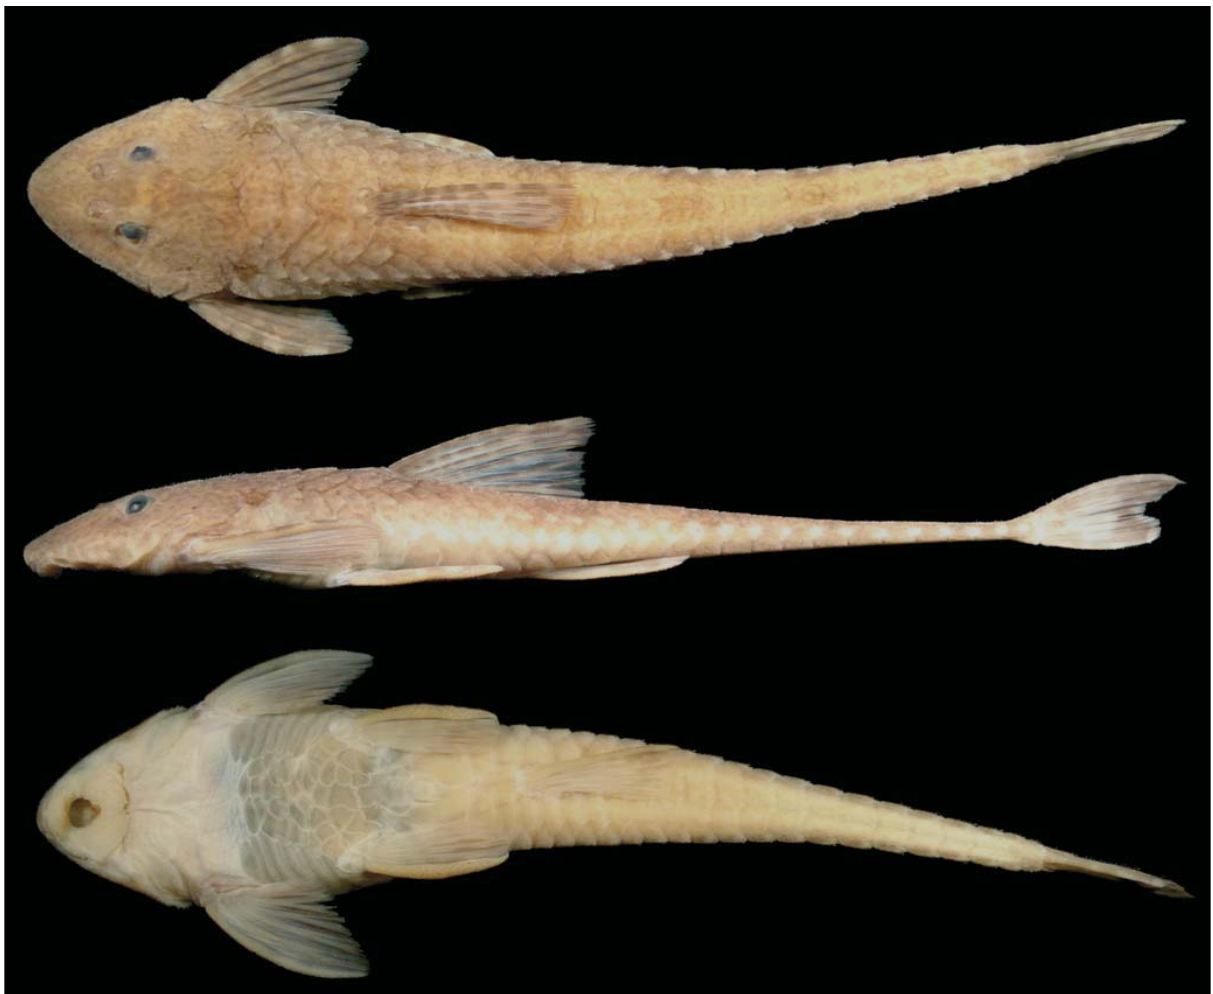
Fig. 4. Rineloricaria maacki , paratype, female, MHNCI 11457, 113.00 mm SL, rio Iguaçu, União da Vitória, Paraná,